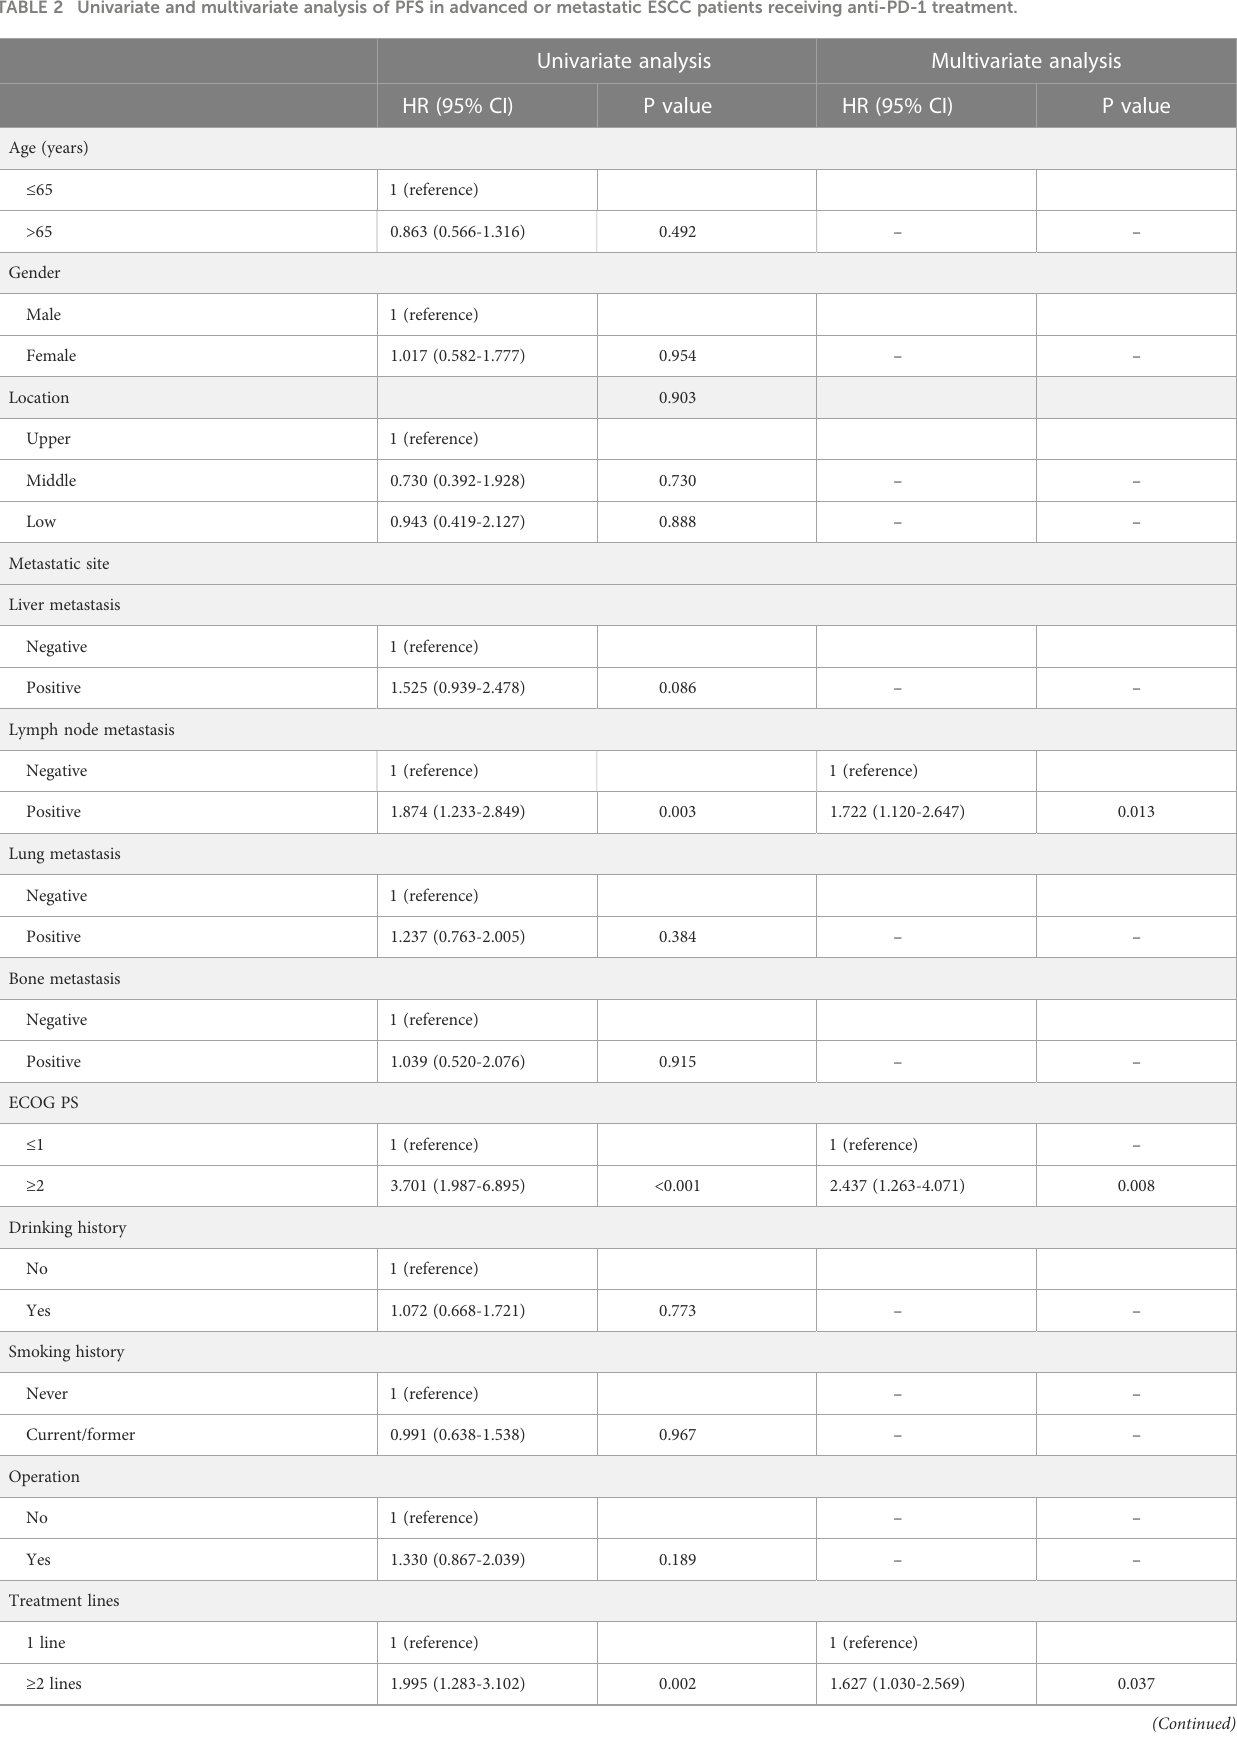
TABLE 2 Univariate and multivariate analysis of PFS in advanced or metastatic ESCC patients receiving anti-PD-1